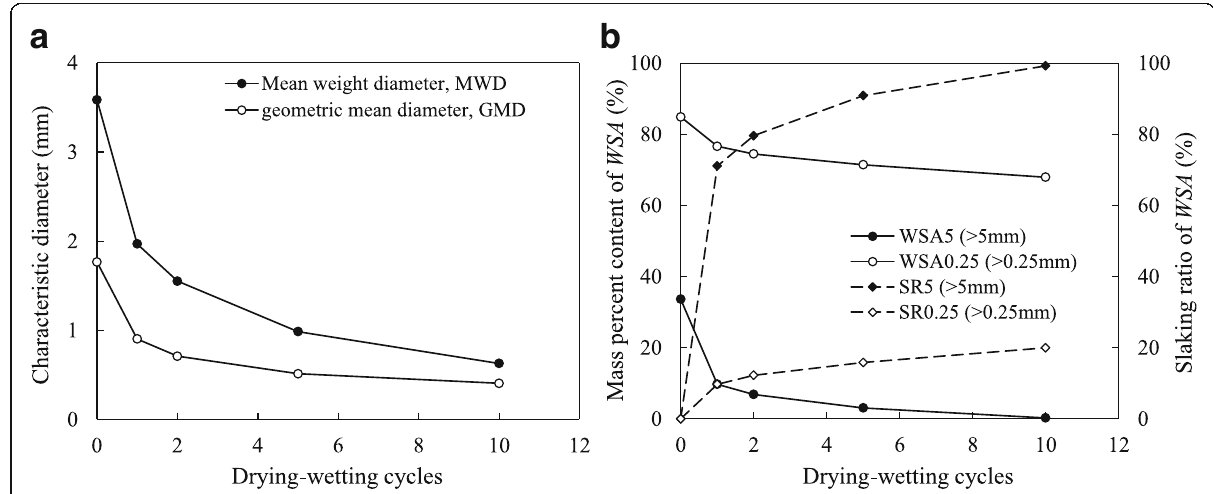
Fig. 6 ( a ) Characteristic diameters of water – stable aggregates under drying – wetting cycles; ( b ) variations of water stability and slaking ratio